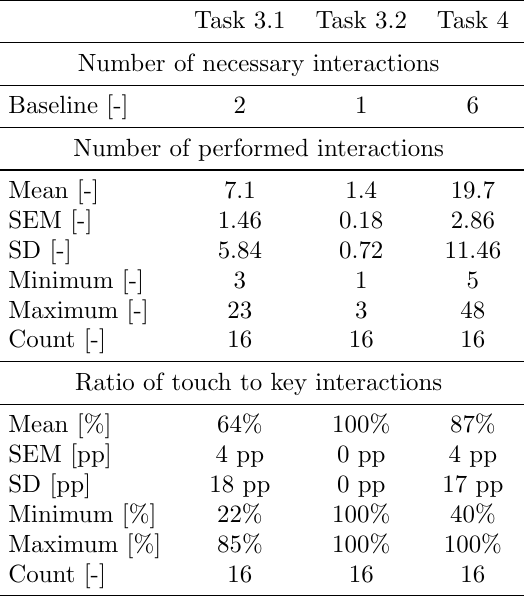
Table 6: Quantitative results of interactions with FGUI Task 3.1 Task 3.2 Task 4